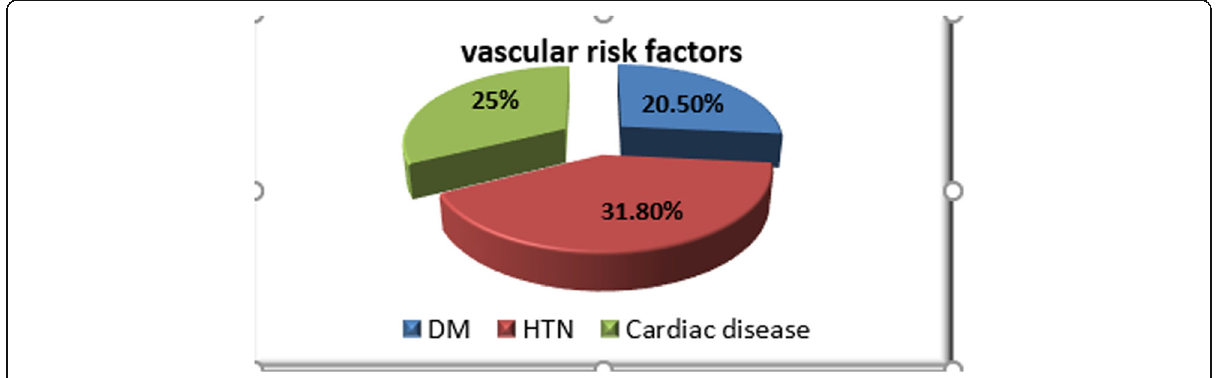
Fig. 1 Distribution of vascular risk factors among the patient